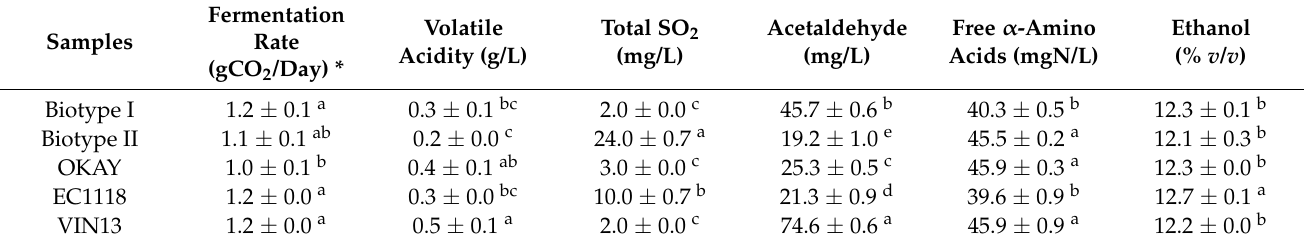
Table 4. Main analytical characteristics of wines obtained by the two dominant biotypes compared with commercial starter strains, fermented at 22 ◦ C. Data are means ± standard deviations, and those with different superscript letters ( a–e ) within each column are significantly different, according to Duncan’s test ( p -value <